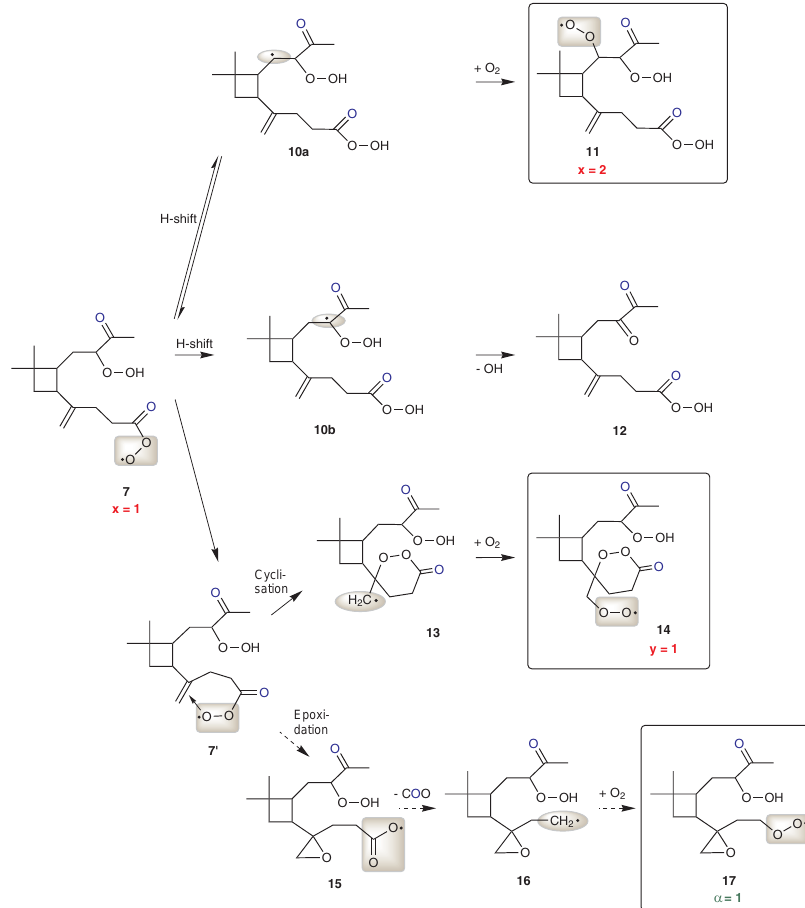
Figure 8. Further reaction steps of the RO 2 radical (7). Oxygen atoms arising from the attacking ozone are highlighted in blue, alkyl radical functions with a shaded oval and RO 2 radical functional groups with a shaded rectangle. Detected species are surrounded by a solid rectangle. The stated position, where the internal H-transfer takes place 7 → 10a, represents an example only. The dashed arrows indicate that the stated reaction pathway remains